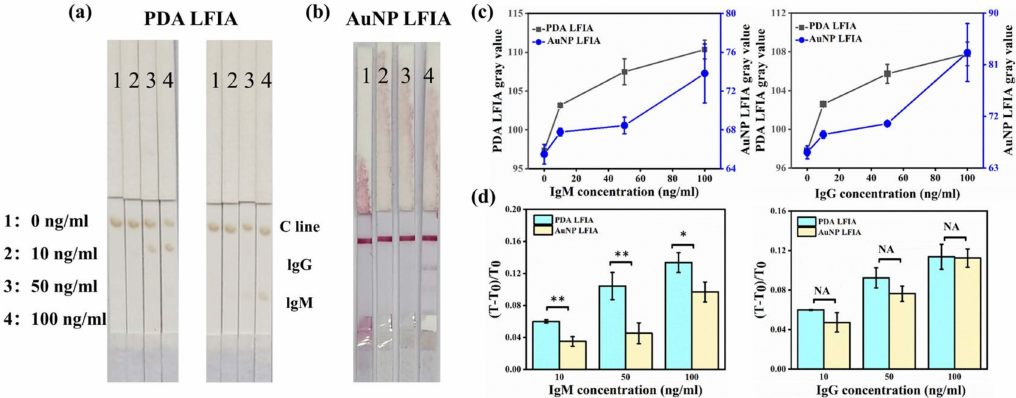
Figure 4. Comparison of PDA-based LFIA and AuNP-based LFIA for COVID-19 IgG and IgM detection. ( a ) Detection results of PDA-based three-line LFIA for IgG and IgM with different concen- trations. ( b ) Detection results of AuNP-based LFIA for IgG and IgM with different concentrations. ( c , d ) Comparison of the quantification results of COVID-19 IgM and IgG detection. p < 0.05 indicates significant difference (*) and p < 0.01 indicates extremely significant difference